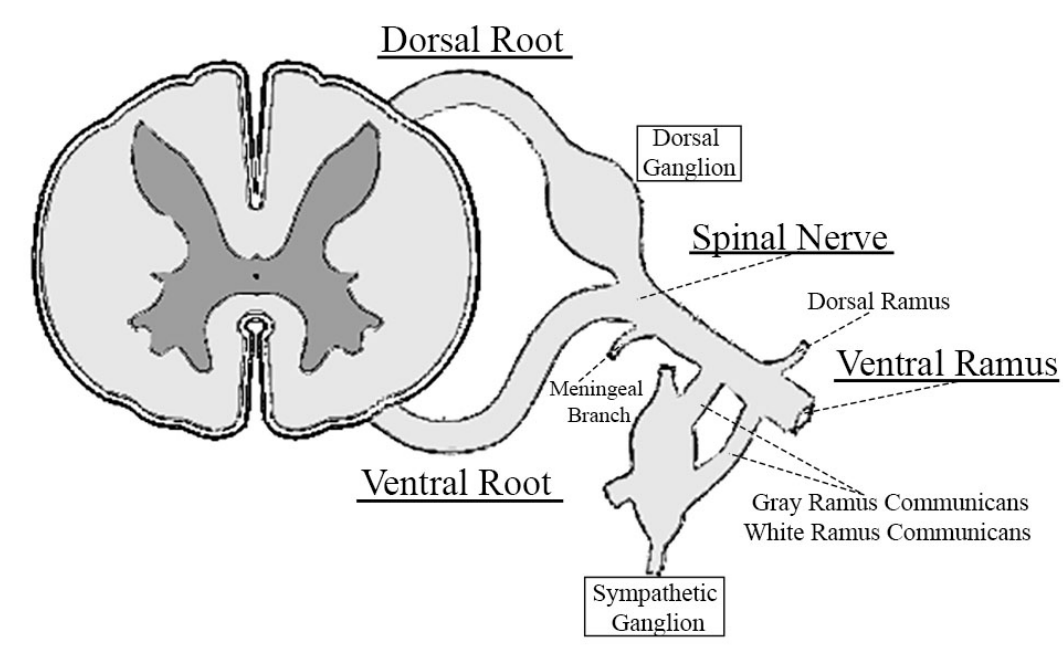
Figure 1. Anatomy of a spinal nerve and its branching pattern.